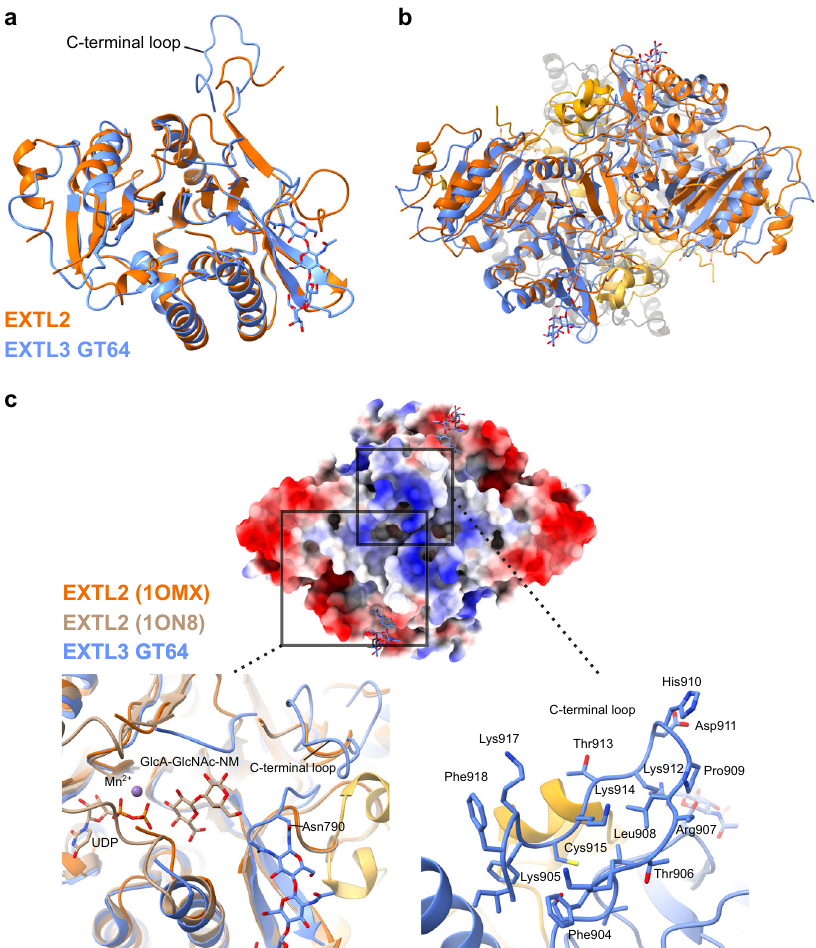
Fig. 4 The GT64 domain of EXTL3 shows high similarity with that of EXTL2 from mouse, but differs substantially in the C-terminal loop. a Individual EXTL3 GT64 domain (blue) aligned to a single murine apo-EXTL2 monomer (PDB: 1OMX; orange). b Complete homodimeric EXTL2 structure (orange) aligned to homodimeric EXTL3 (coloured as in Fig. 3) via an individual EXTL2 GT64 domain. c Top surface of EXTL3, coloured by electrostatic potential (blue: most positive; red: most negative). Bottom left: Alignment of murine apo-EXTL2 (orange), EXTL3 (coloured as in Fig. 3), and murine EXTL2 bound with UDP and an acceptor analogue mimicking the fi nal two residues of the tetrasaccharide linker (GlcA- β 1,3-Gal- β 1- O -naphthalenemethanol; ‘ GlcA- GlcNAc-NM ’ ) (PDB: 1ON8; tan), showing the GT64 acceptor binding cleft. The visible C-terminal loop in EXTL3 is provided by the opposing monomer. Bottom right: Close-up of the C-terminal loop. The side chain of Arg907 was not modelled due to lack of